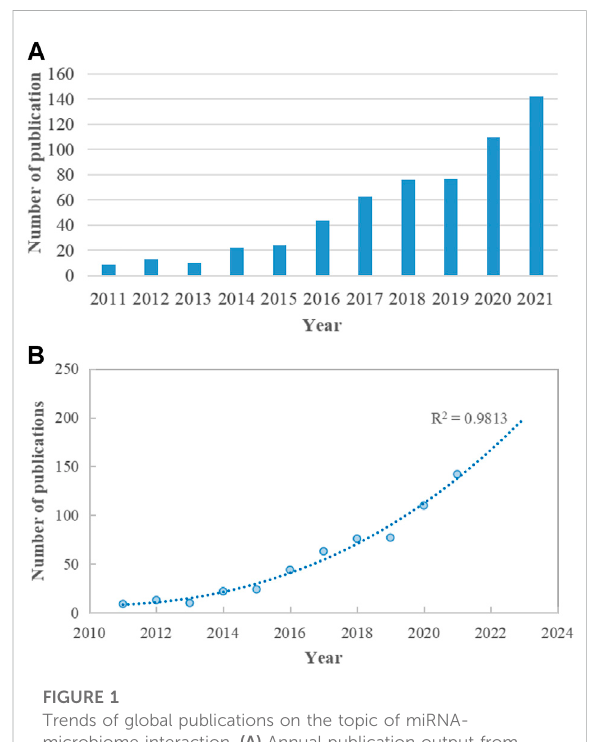
FIGURE 1 Trends of global publications on the topic of miRNA- microbiome interaction. (A) Annual publication output from 2011 to 2021. (B) Logistic regression model of growth trends in